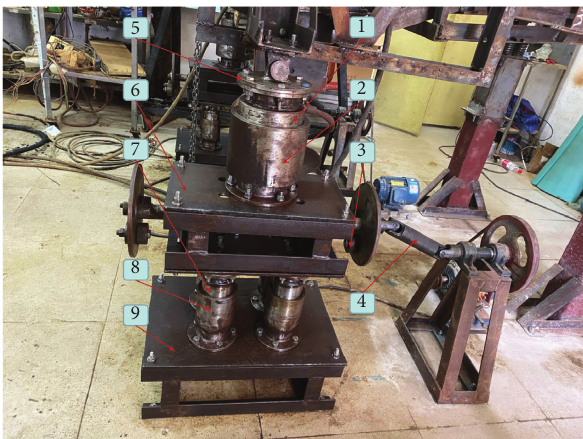
Figure 3: The SSFE II.1 and 2: the external and the internal sleeves of the upper spring; 3: eccentric mass blocks; 4: the axis coupler; 5, 6, and 9: the upper, the middle, and the lower support platforms; 7 and 8: the external and the internal sleeves of a lower spring.